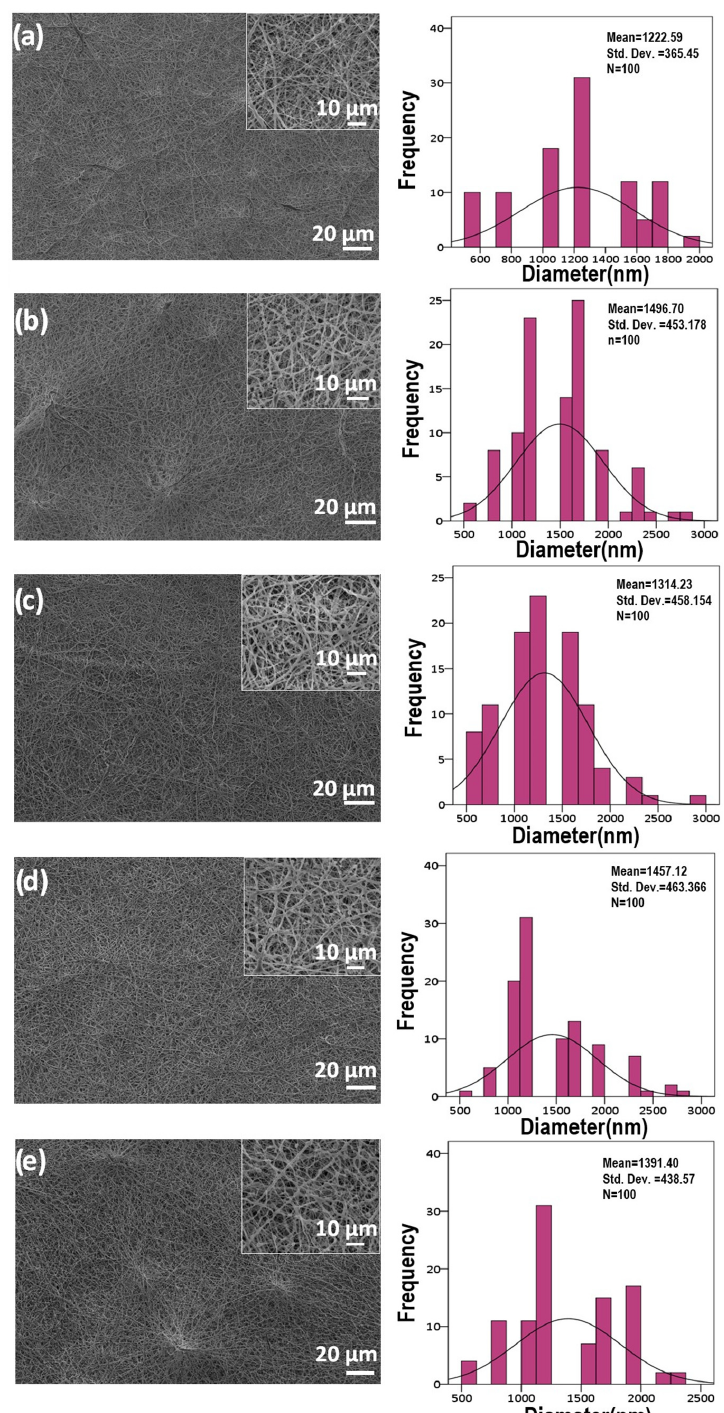
Figure 2. SEM images and fiber diameter distribution of the 25% PCL ( a ), 25% PCL/0.1% BFO ( b ), 25% PCL/0.1% BFO/1Q ( c ), 25% PCL/0.1% BFO/3Q ( d ) and 25% PCL/0.1% BFO/5Q ( e ) microfibrous scaffolds.